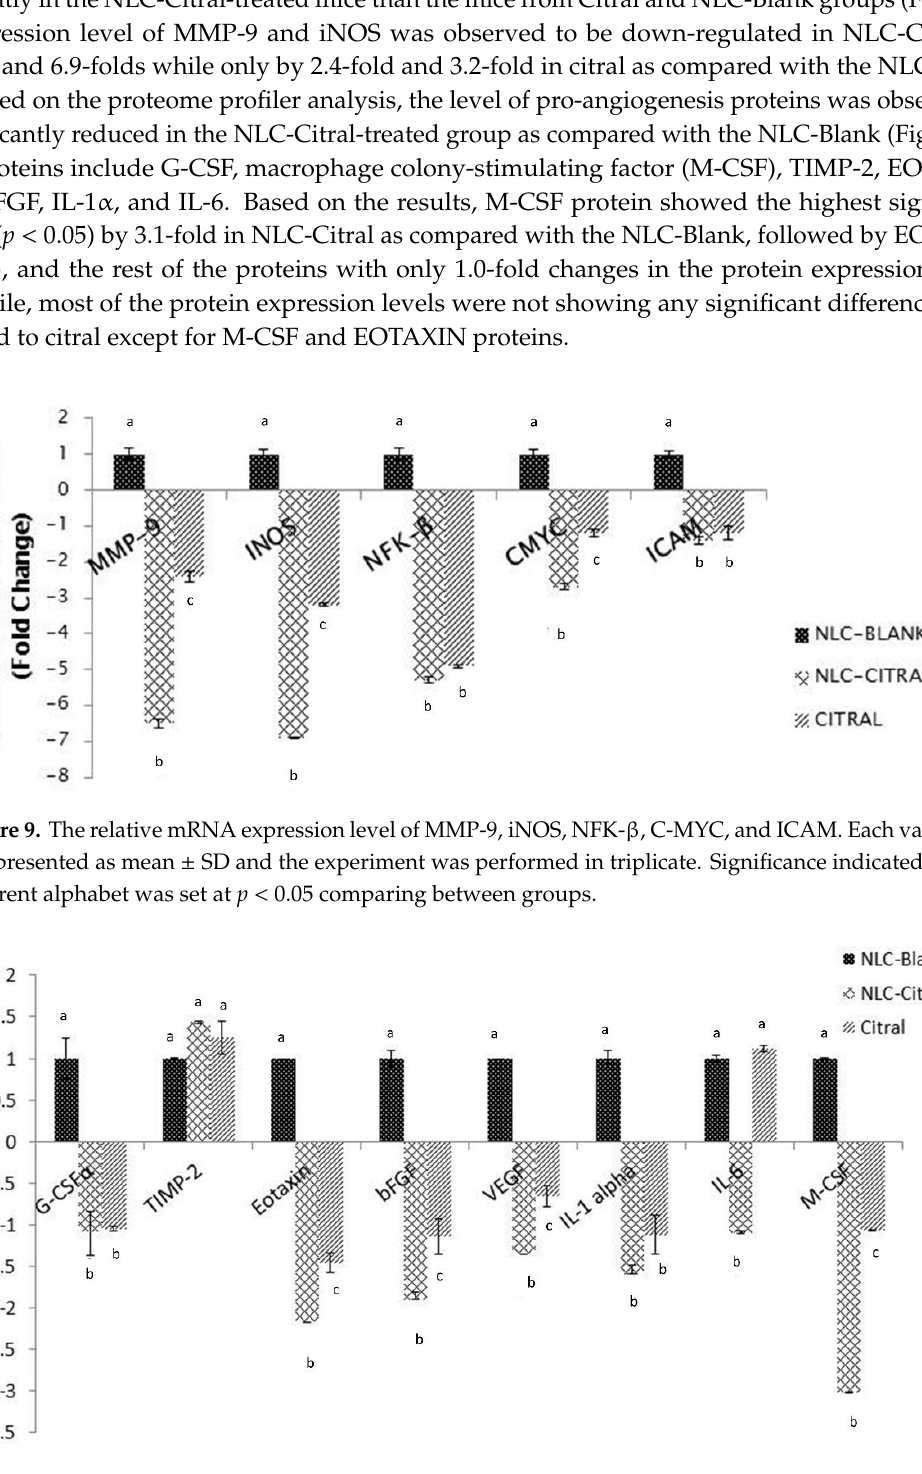
Figure 10. Angiogenesis proteome profiler analysis of the tumor harvested from each group. Each value is represented as mean ± SD and the experiment was performed in triplicate. Significance indicated by di ff erent alphabet was set at p < 0.05 comparing between